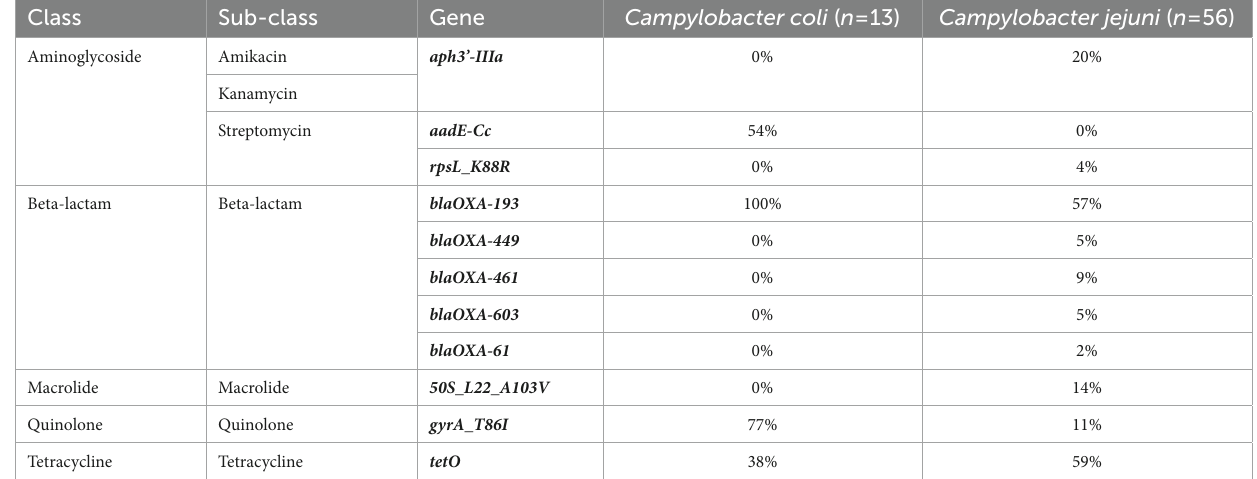
TABLE 6 Antimicrobial resistance genes in thermophilic Campylobacter